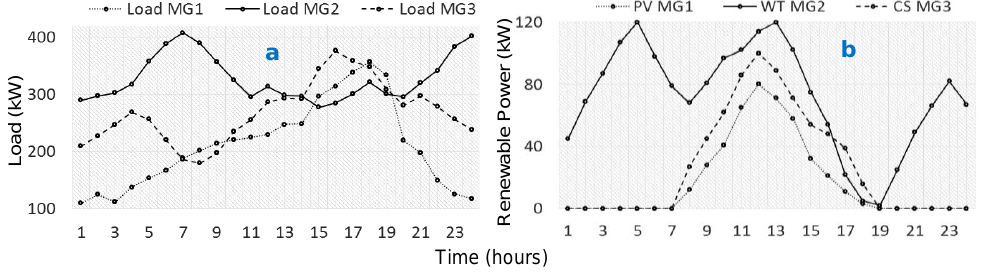
Figure 4. ( a ) Hourly electric load of microgrids (MGs); and ( b ) Hourly renewable generation outputs in each microgrid (MG). Table 1. Parameters related to energy resources in each MG.